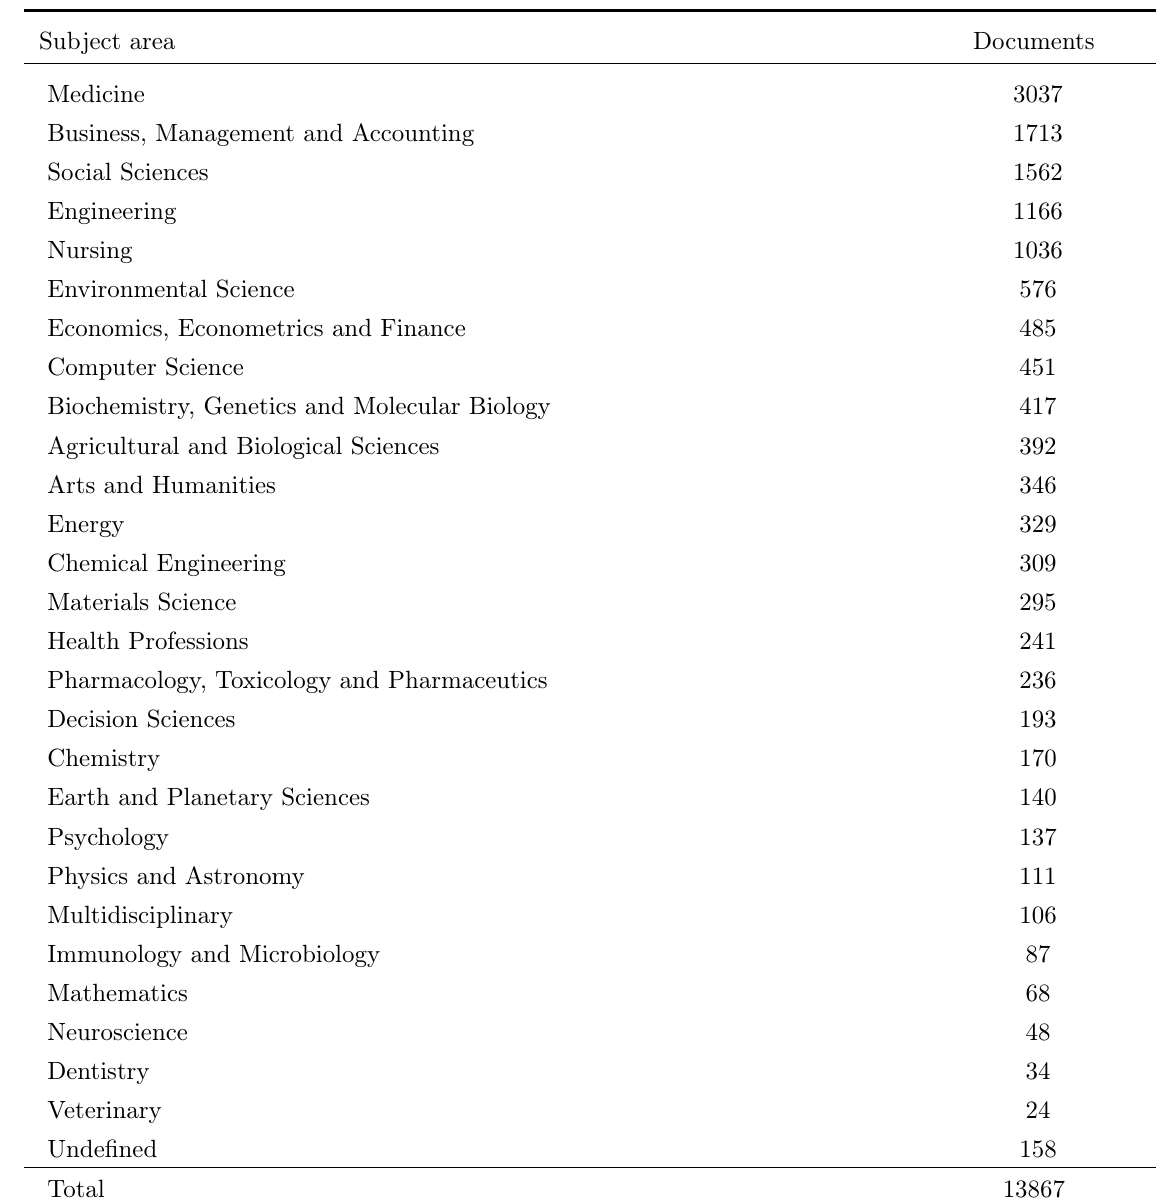
Table 1. Number of documents per subject area in SCOPUS using the search: KEY (innovation) AND (LIMIT-TO (DOCTYPE,